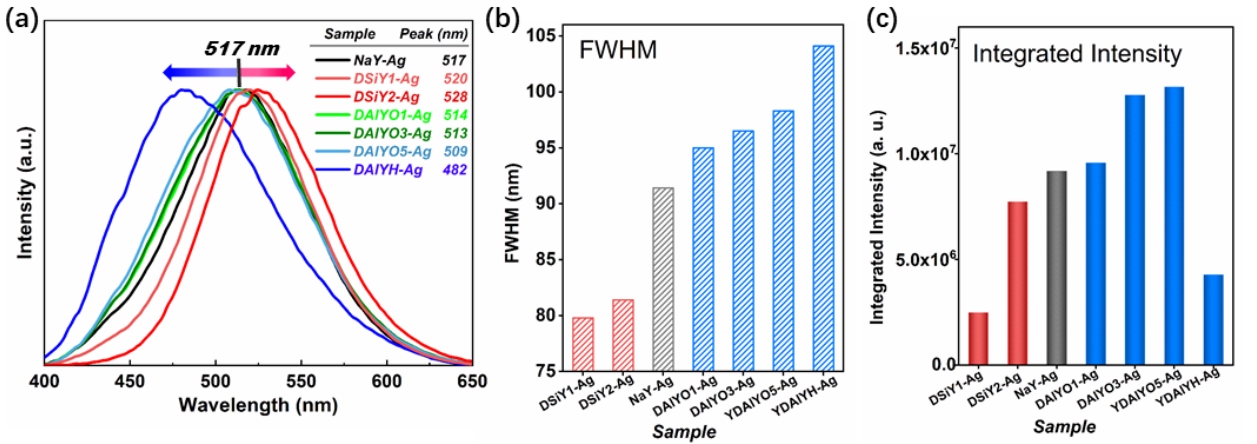
Figure 4. Normalized PL spectra ( a ), FWHM of the PL spectra ( b ), and integrated intensities ( c ) for NaY-Ag, DSiY1-Ag, DSiY2-Ag, DAlYO1-Ag, DAlYO3-Ag, DAlYO5-Ag, and DAlYH-Ag.